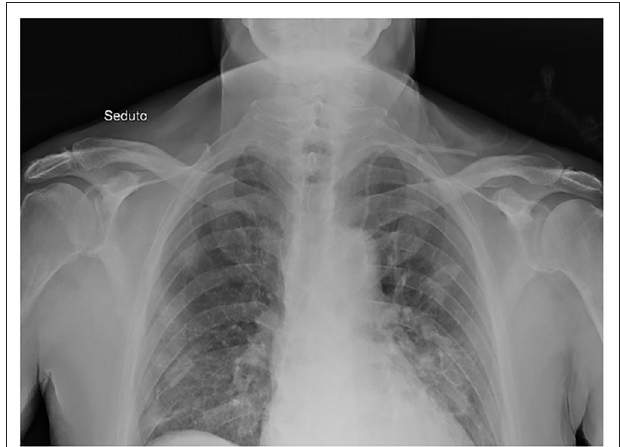
FIGURE 2 | Chest X-ray. Chest X-ray description: small peripheral hazy opacity in medium field and more evident opacities at the medium-lower fields of both lungs, especially on the left